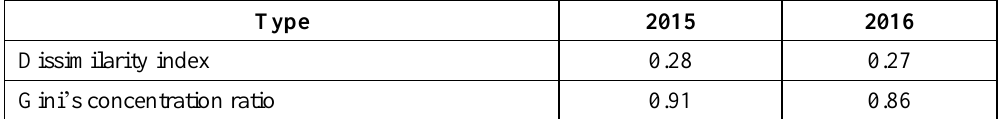
Table 1. Measure of inequality for non-life Baltic insurance market,